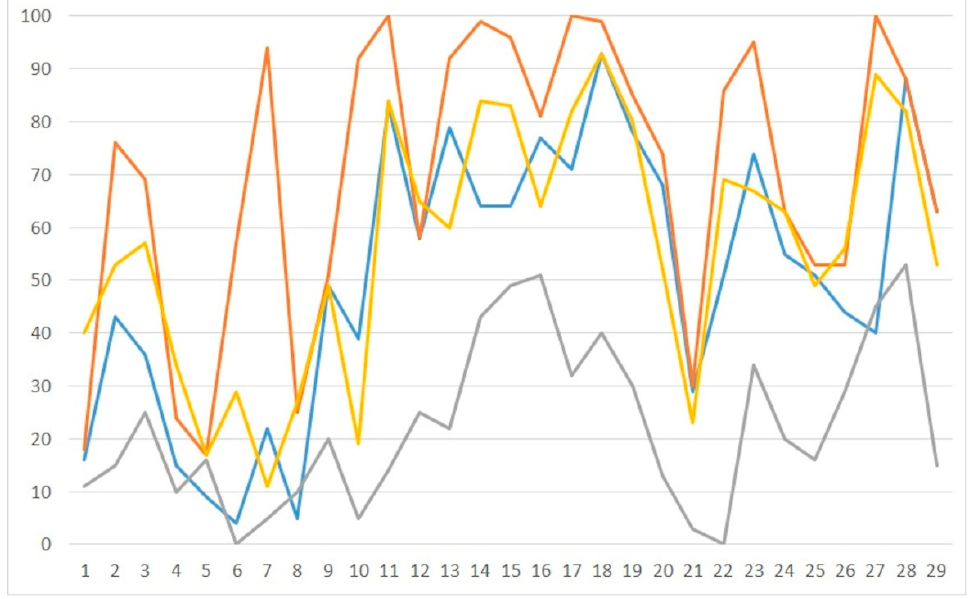
Figure 3. The MA M values for NAUTILUS (blue line), CAB (red line), ARP/wARP (grey line) and PHENIX.AUTOBUILD (yellow line). The numbers on the horizontal axis correspond to the order enstries of the test structures in Tables 2 and 4.